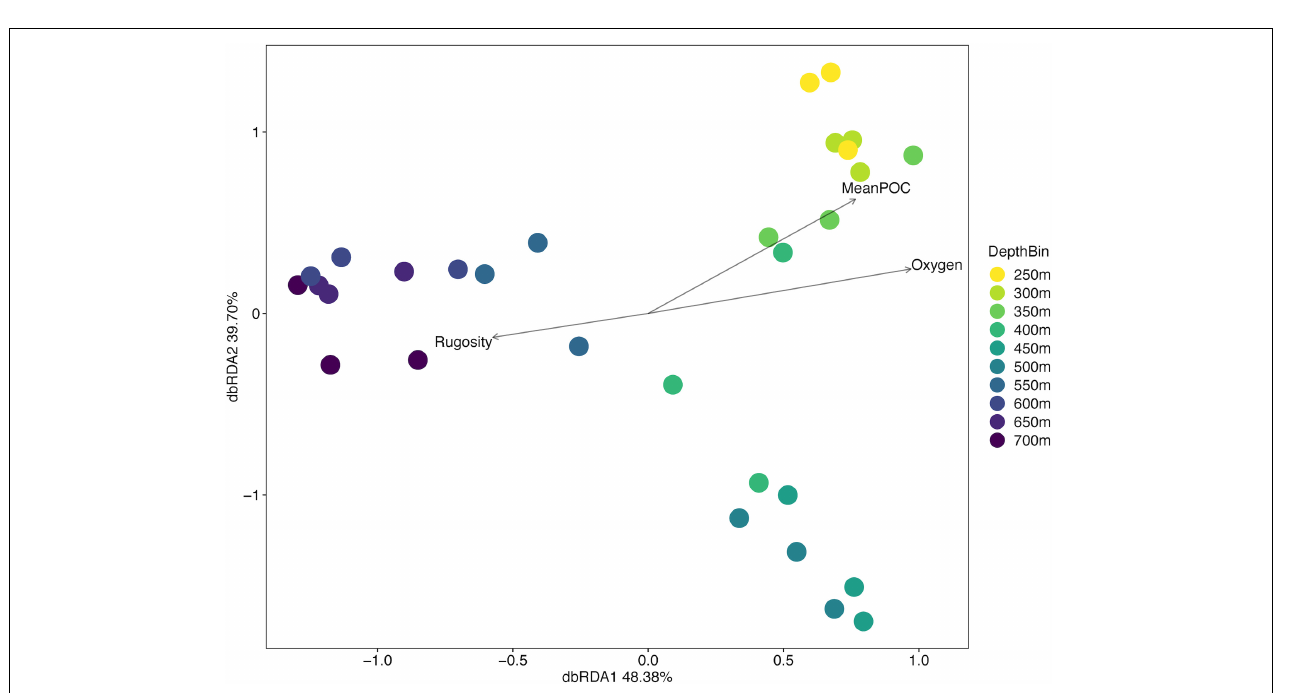
FIGURE 5 | Distance-based redundancy analysis diagram for the North side of Mokumanamana coded by depth.